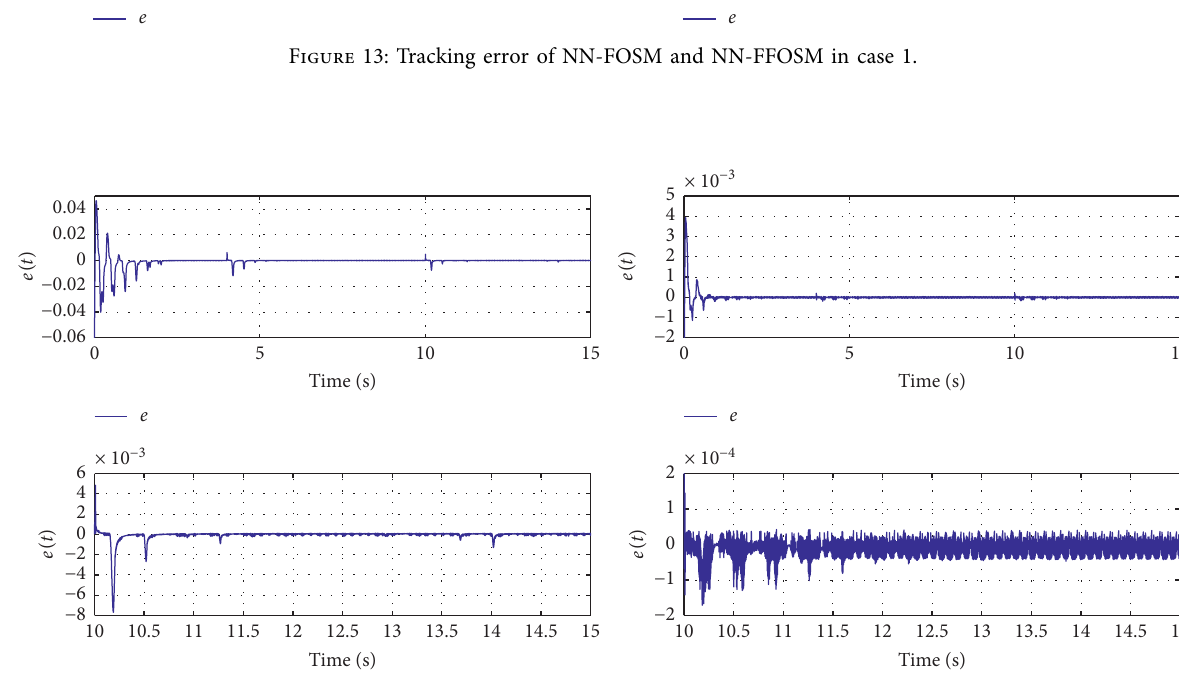
Figure 13: Tracking error of NN-FOSM and NN-FFOSM in case 1.